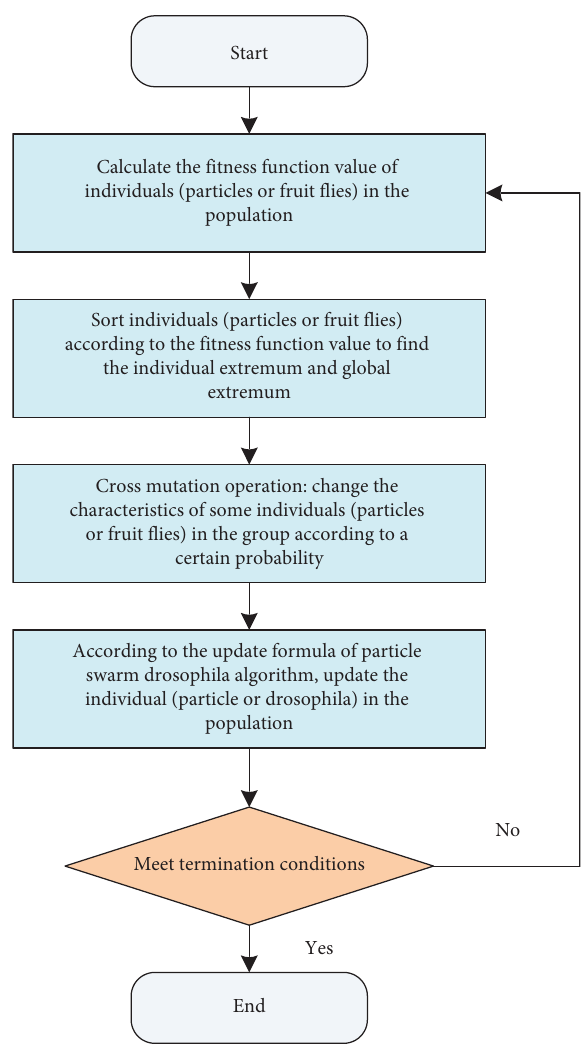
Figure 7: Flowchart of the FOAPSO-GA